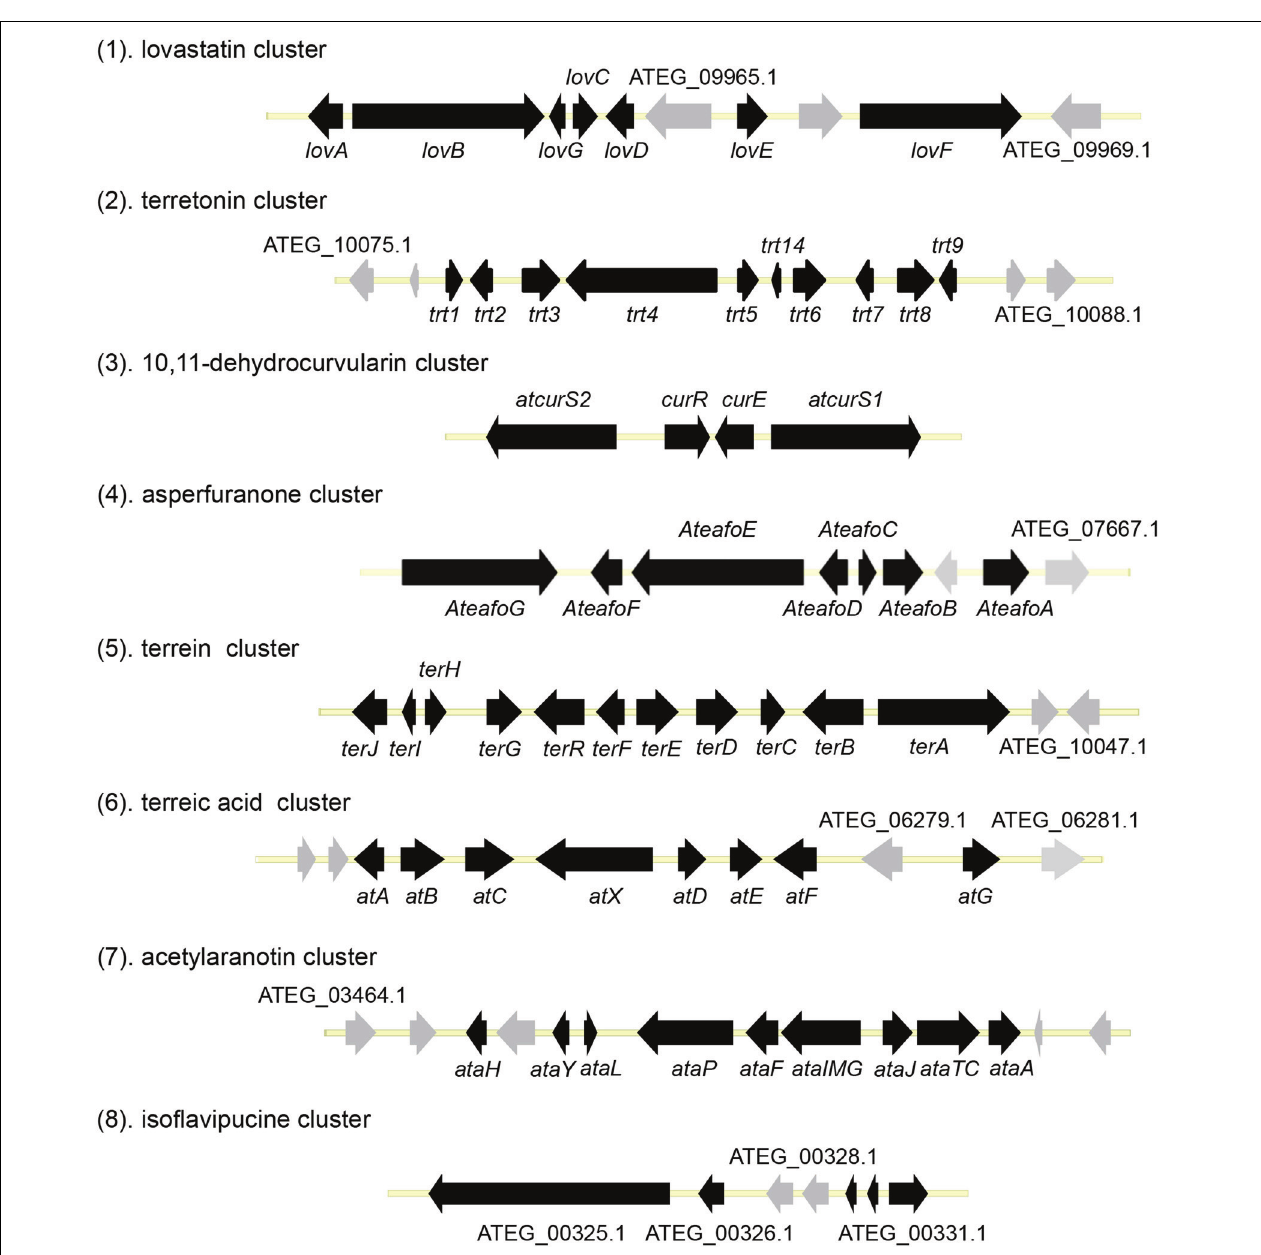
FIGURE 1 | Organization of the secondary metabolite gene clusters identified in A. terreus